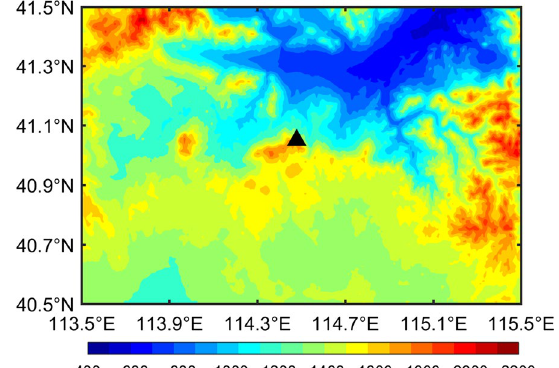
Fig. 1 Location of Zhangbei wind farm (the black solid triangle denotes the observation